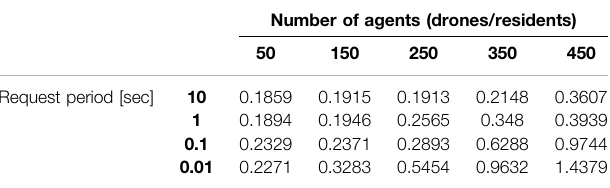
Table 1 contains the average values of the system response TABLE 1 | Average response times with different request periods and number of agents concurrently accessing the cloud. Number of agents